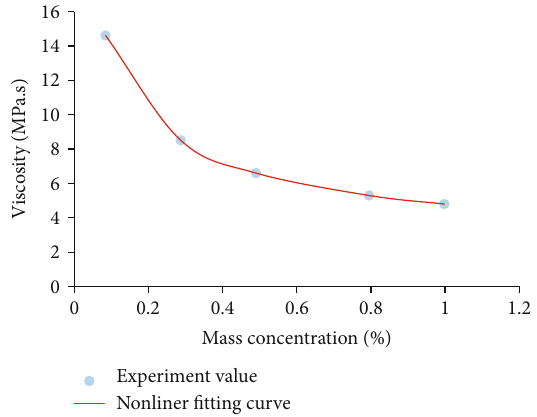
Figure 8: Crude oil viscosity change fi tting